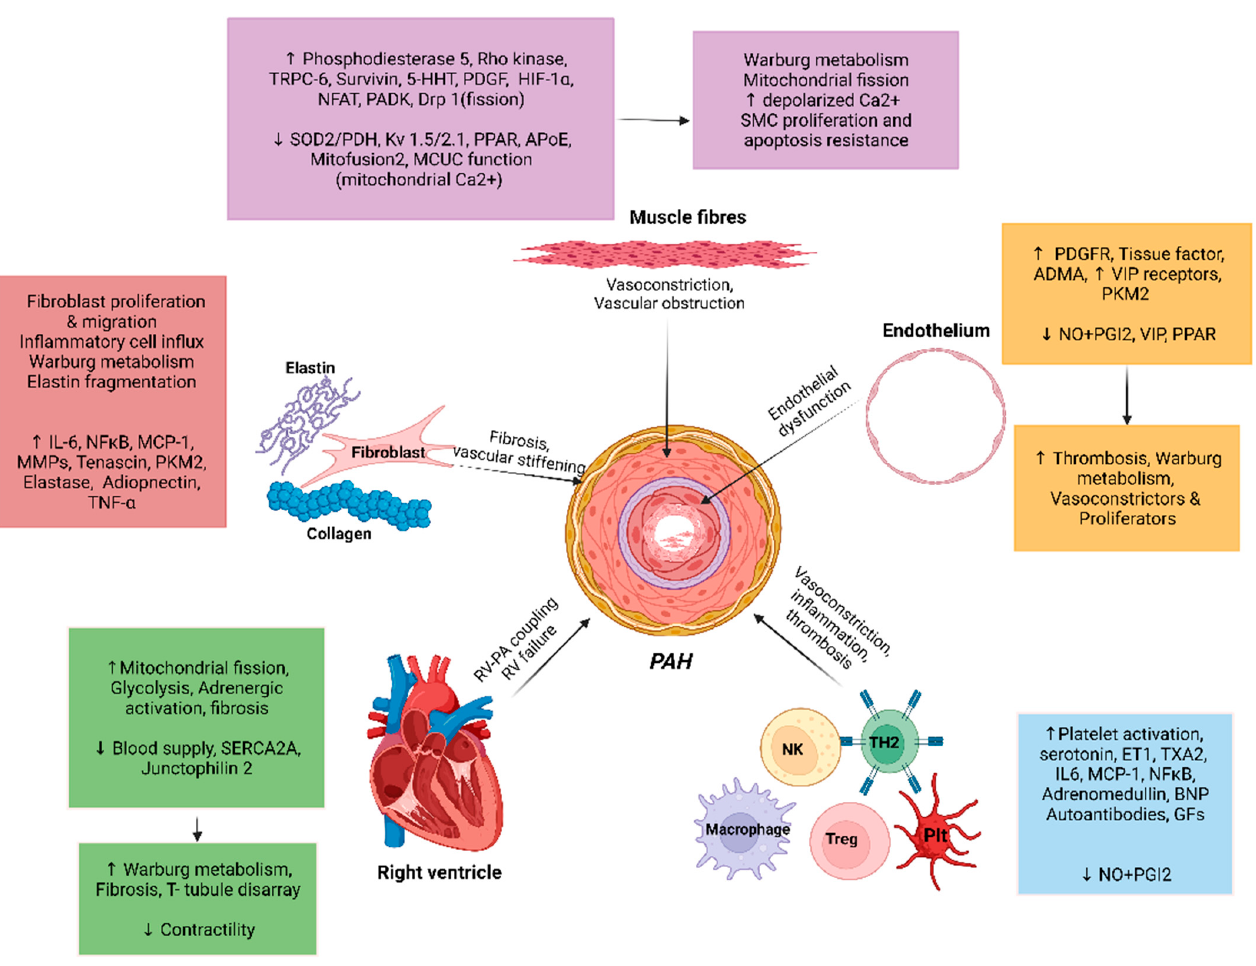
Figure 1. Pathogenesis of pulmonary artery hypertension. 5-HHT: 5 Hydroxy tryptamine; Apo E: